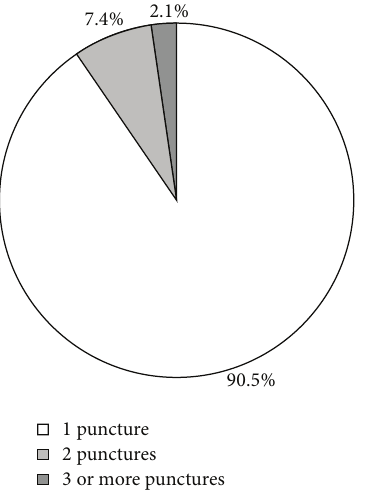
Figure 2: Numbers of CSF samples needed to establish the cytolog- ical diagnosis. Most of the diagnoses could be established already with the first puncture, while the second and consecutive samples only added a minor part of additional